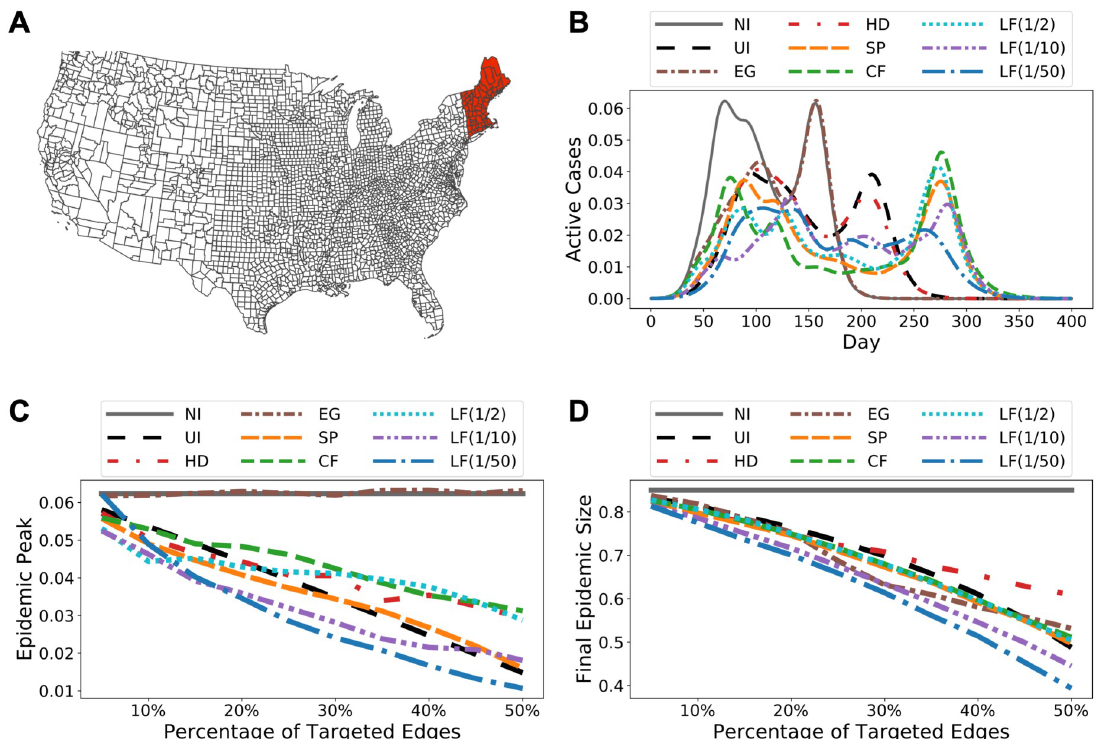
Fig 3. Simulation results for Facebook County. (A) Initially infected cluster of counties. (B) Predicted epidemic curves at 25% coverage level, i.e., intervention is applied to 25% of all edges, along with the original epidemic curve without intervention (NI). The abbreviations a . (C) Predicted epidemic peaks (peak prevalence) over a range of intervention coverage levels. (D) Predicted epidemic sizes (total infection) over a range of intervention coverage levels. Observe that EG intervention does not reduce peak prevalence at all. This is likely